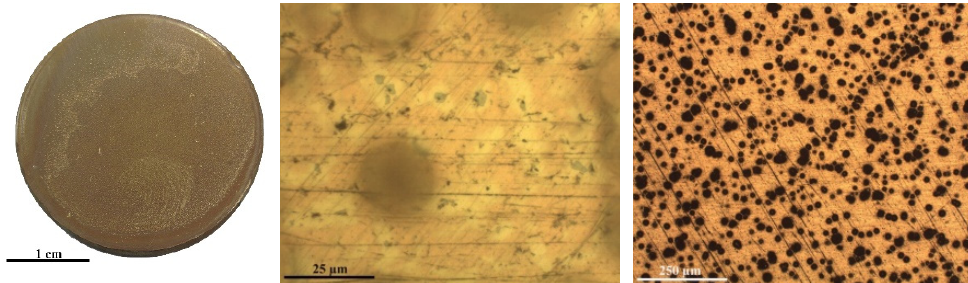
Figure 5. General appearance and OM micrographs of the bare Cu-based coated with a thin chitosan film with 0.5 mg/mL cysteine after an accelerated corrosion treatment was carried out for 250 min.